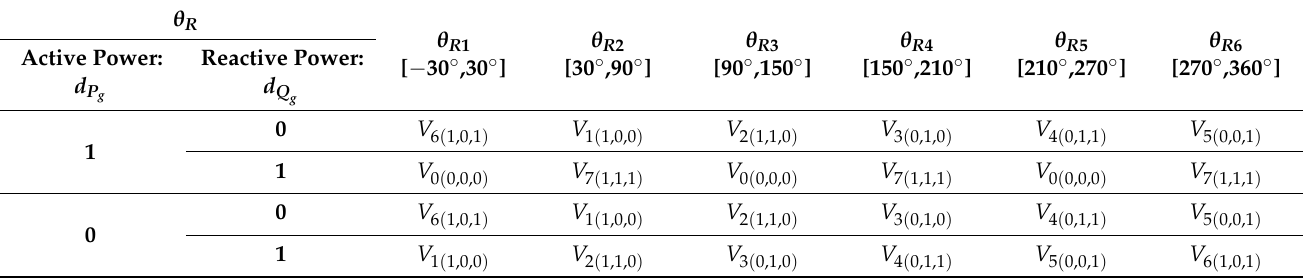
Table 4. Inverter switching table for 6 sectors.